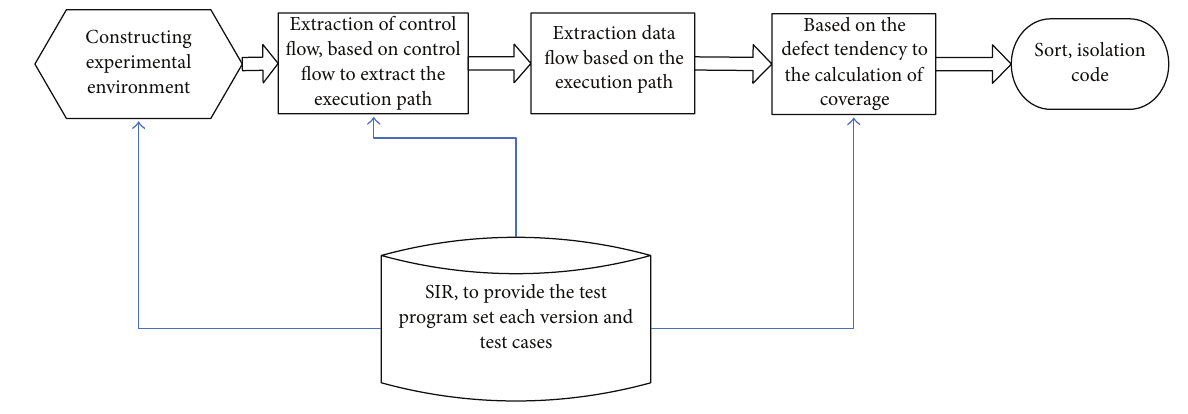
Figure 5: System structure